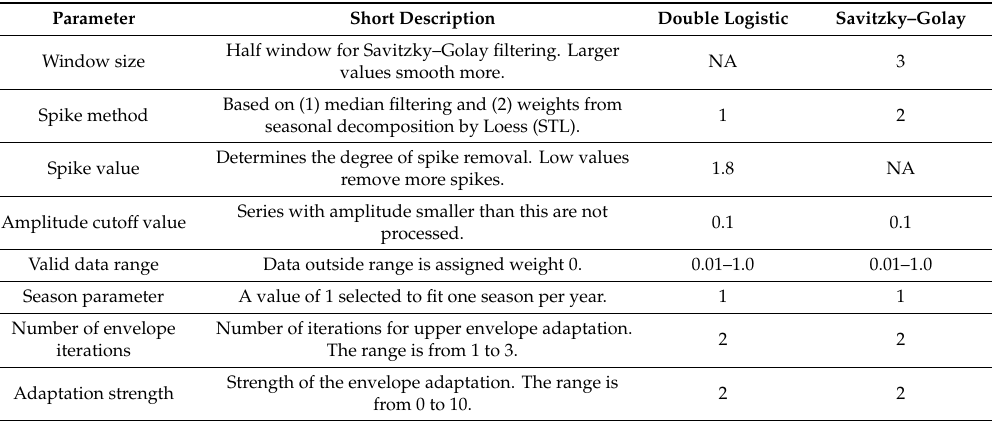
Figure 2. EVI time series with di ff erent fitting methods and phenological transition date thresholds. Panel ( a ) shows double logistic (black) and Savitzky–Golay (blue) fits to time series of enhanced vegetation index (EVI). Panel ( b ) shows the two di ff erent thresholds corresponding to 10% (blue, solid line) and 15% (purple, dashed line) of the seasonal amplitude of EVI in spring and fall. Panels ( c , d ) are sample time series of EVI at two di ff erent locations: Evergreen Needleleaf Forest in Central Canada and Savanna in the US Southwest. Table 1. Input settings for time series processing in TIMESAT for two di ff erent fitting methods: double logistic and Savitzky–Golay, as recommended by [44]. Short Description Double Logistic